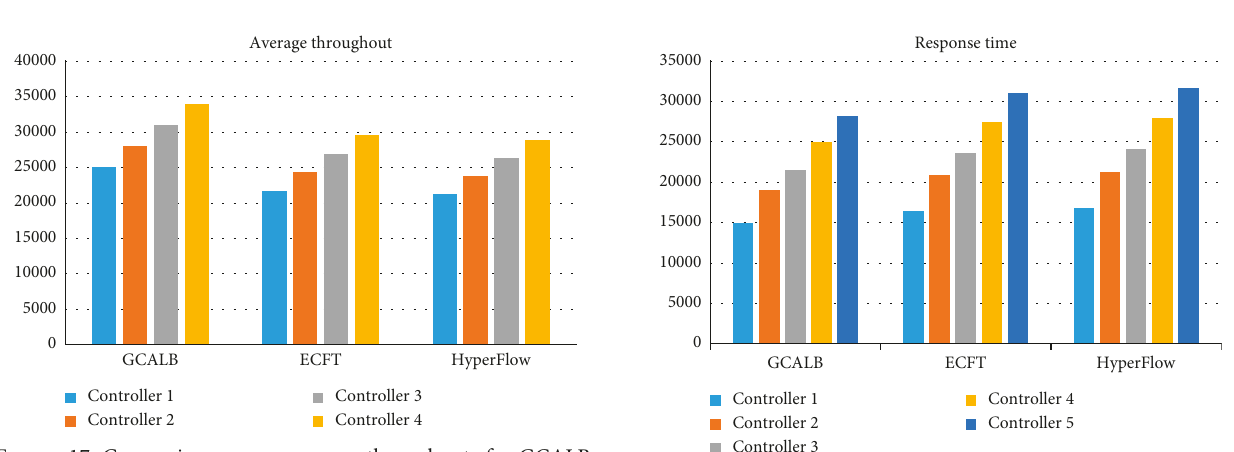
Figure 20: Average response time for GCALB, ECFT, and HyperFlow among five